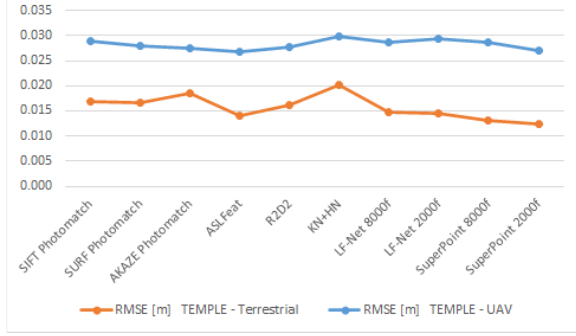
Figure 6: RMSE [m] for the Neptune Temple datasets. In both cases (terrestrial and UAV), the RMSE variation is very limited, the different methods behave in a similar way, especially in the UAV dataset where the sensor-object distance is very high.